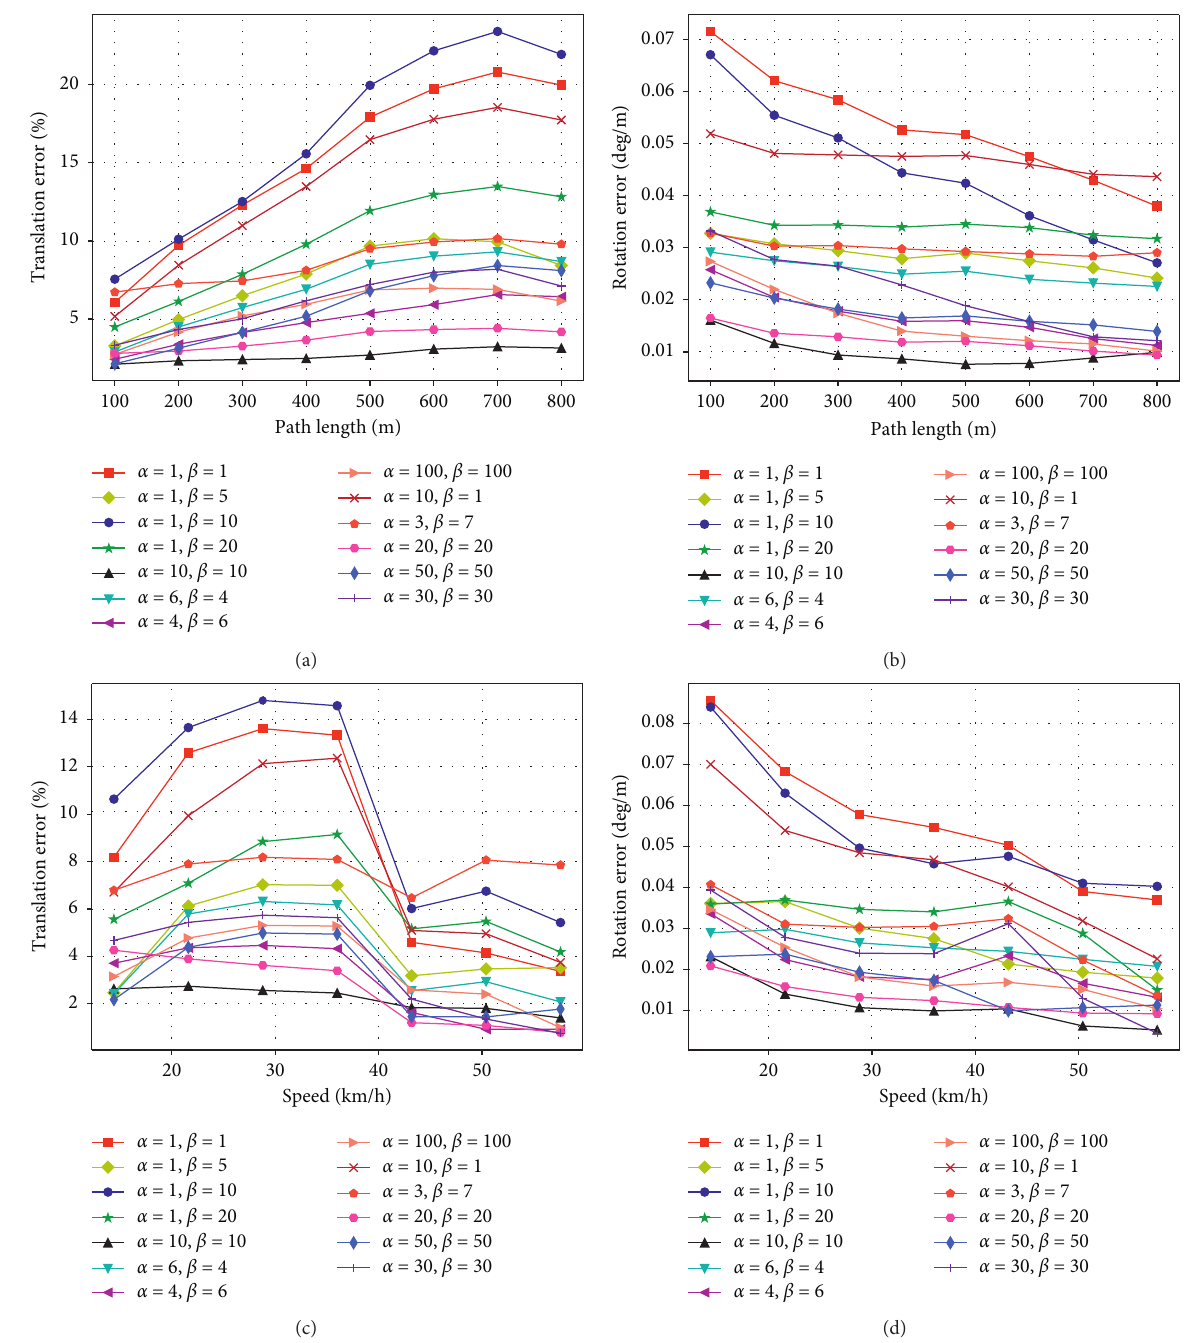
Figure 5: Average errors of the trained model on some results of loss function with different α and β . (a) Translation error against path length. (b) Rotation error against path length. (c) Translation error against speed. (d) Rotation error against